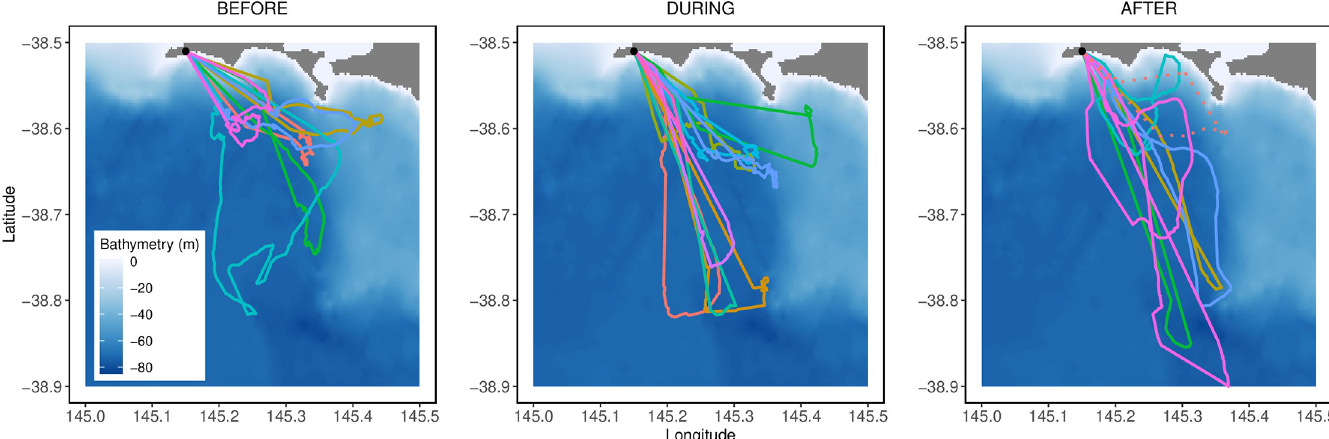
Fig 2. Foraging tracks of little penguins from the Phillip Island colony (black dot) before (from 20 th to 21 st ), during (from 22 nd to 24 th ) and after (from 27 th to 29 th ) a storm event in November 2018. Bathymetry is represented as a blue hue with darker tones indicating deeper waters. The dotted track represents bird #3005.